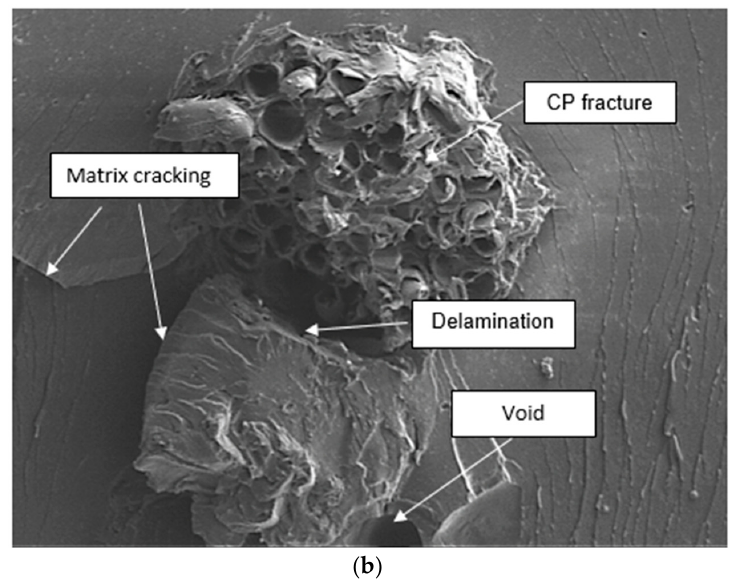
Figure 8. Scanning electron microscopy (SEM) micrographs of tensile fracture surface from ( a ) RH15/CP5 and ( b ) RH0/CP20 wt.%. ( a ) RH15/CP5 and ( b ) RH0/CP20